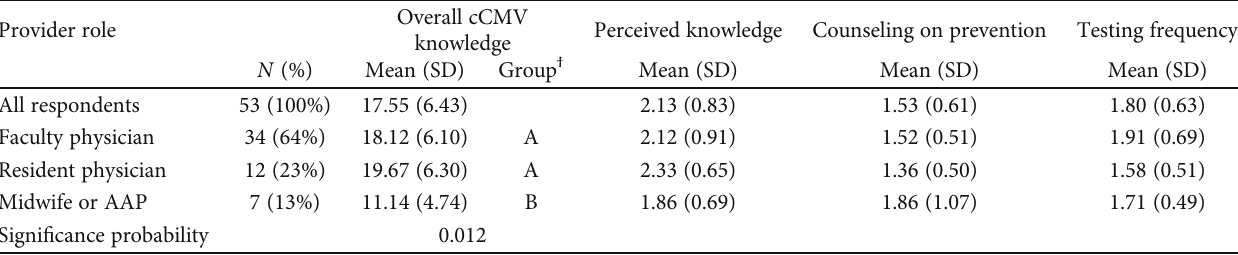
Table 1: Participant characteristics and scores at baseline.